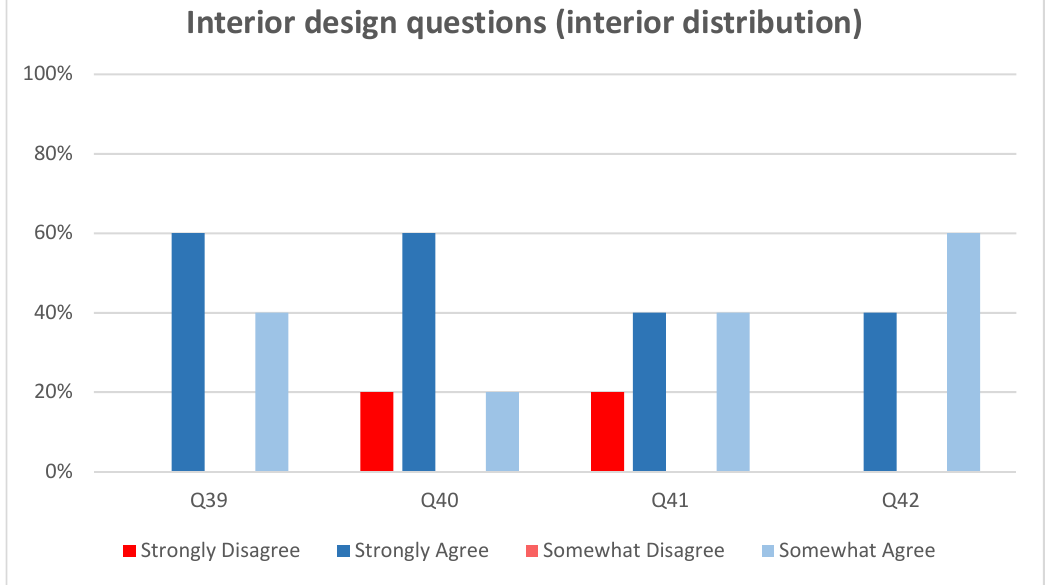
Figure 11 . Results of the questions on interior distribution . Figure 11. Results of the questions on interior